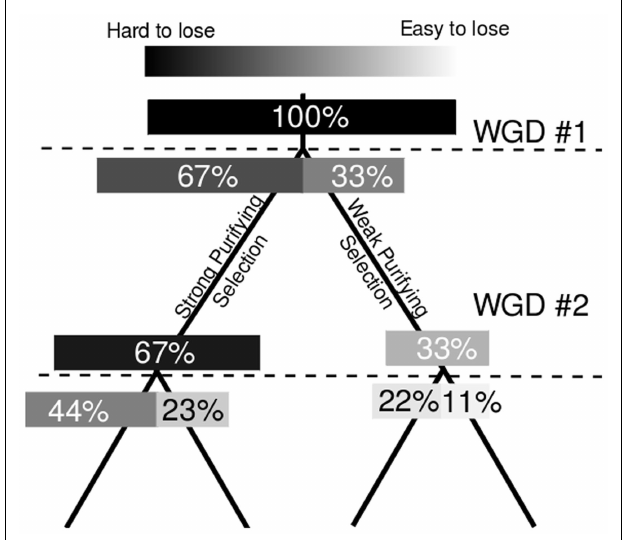
FIGURE 4 | Model for the intrinsic mitigation of gene dosage following multiple rounds of whole genome duplication. On the left, the phylogenetic tree of a perfectly retained gene after two rounds of whole genome duplication. On the right a model of how total expression is partitioned among increasing numbers of gene copies assuming genome dominance. Darkness of individual bars indicates how large an effect the loss of individual gene copies will have on total expression, and, presumably, on